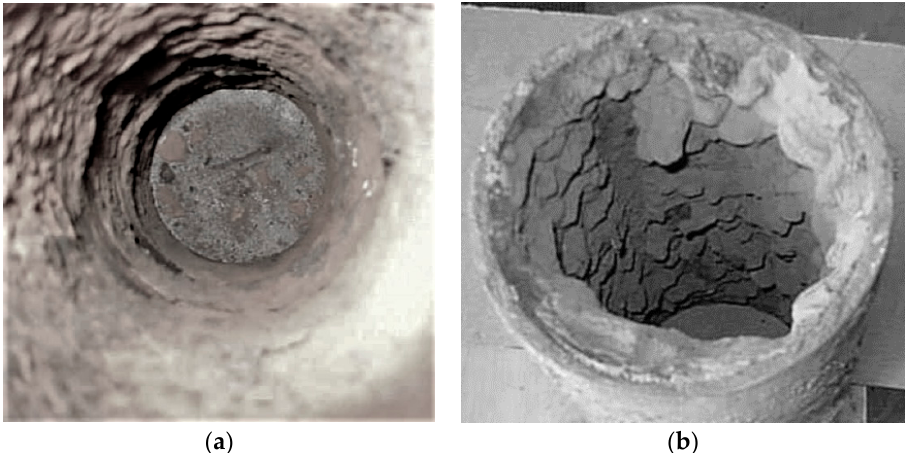
Figure 1. Typical pipe wall build-up: ( a ) evenly distributed roughness; ( b ) unevenly distributed roughness. Samples from Tallinn WDS